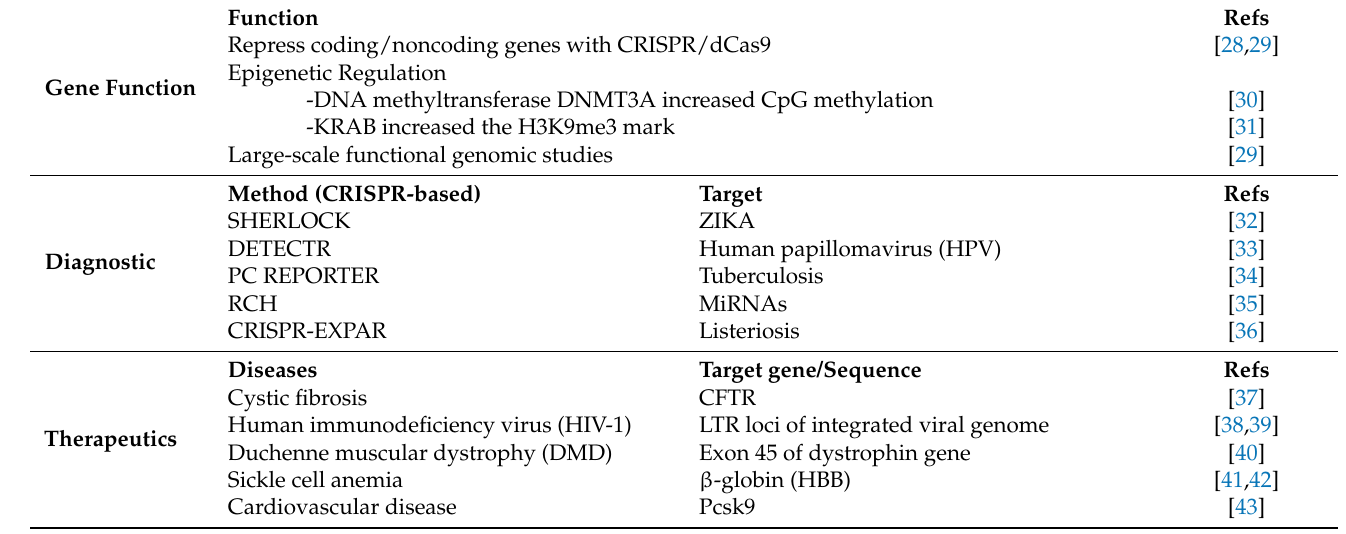
Table 1. Applications of CRISPR